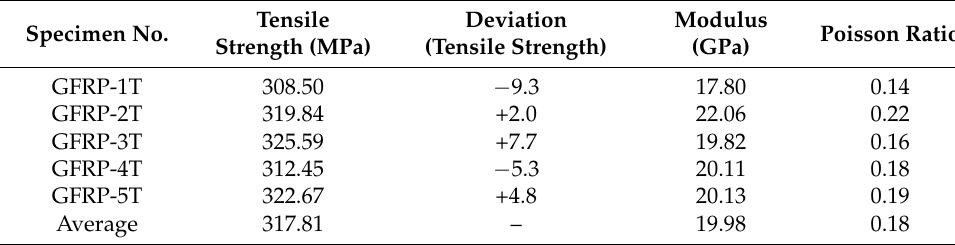
Figure 6. Fracture shape of shear specimen. Table 1. Mechanical properties of tensile specimen.